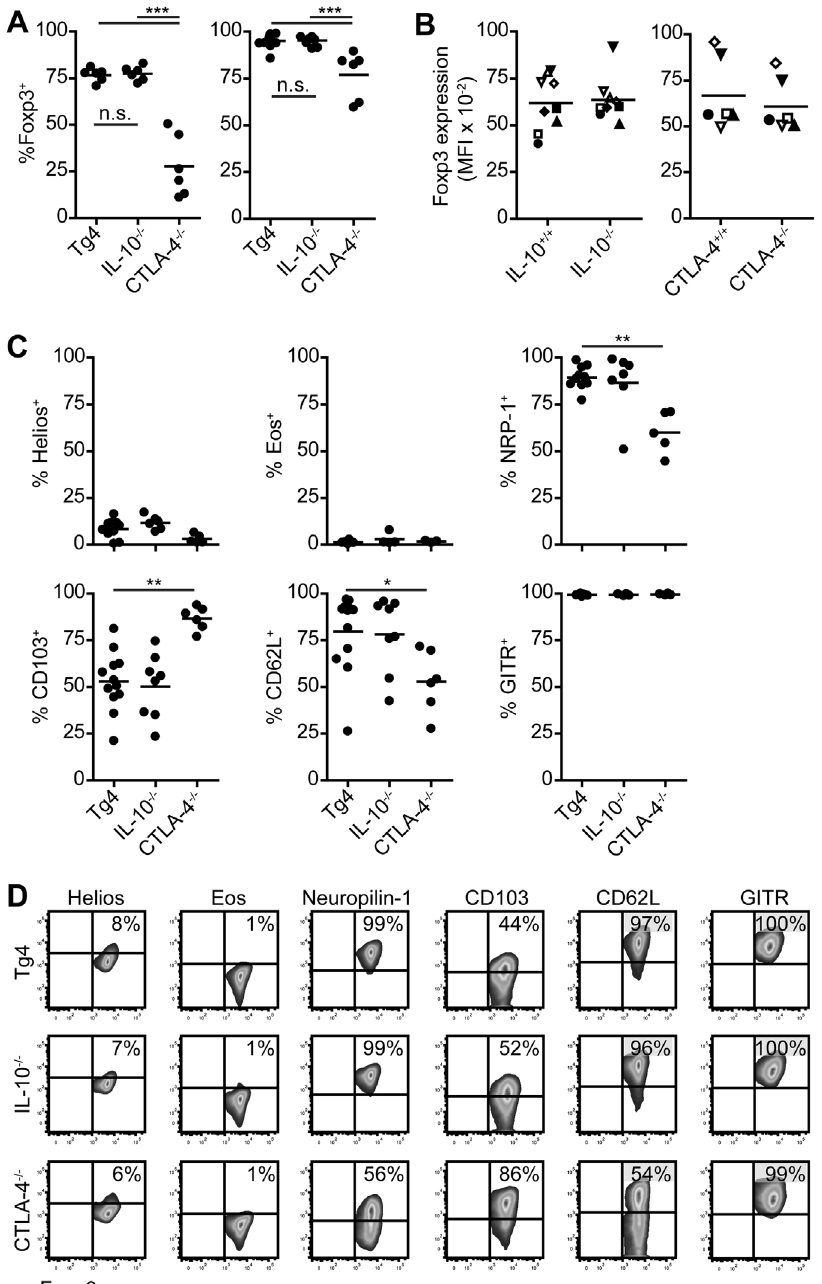
Figure 3. CTLA-4 but not IL-10 deficiency impairs iTreg development. A. Foxp3 expression after 3-day (left) or 7-day (right) culture of naive CD4 + T cells stimulated with plate-bound anti-CD3 and anti-CD28 in the presence of 100 U/ml rhIL-2 and 10 ng/ml rhTGF- b 1 . n=6–14 individual experiments per condition. *** P , 0.001, Tukey’s multiple comparison test. n.s. =not significant. Day 3 and day 7 data are not from the same experiments. B. Median fluorescence of Foxp3 staining on CD4 + Foxp3 + T cells after 7-day culture as in A. Matching symbols in either column in each plot correspond to paired samples. n=6–9. No significant differences; paired, 2-tailed t-test. C + D. Mean expression (C) and representative cytometry plots (D) of transcription factors and surface markers on CD4 + Foxp3 + T cells after 7-day culture as in A. n=3–12 individual experiments per condition. C * P , 0.05, ** P , 0.01, *** P , 0.001, one-way ANOVA with Dunnett’s post-test. doi:10.1371/journal.pone.0108023.g003 subsets, is important for the control of immune responses to self their differentiation. As depicted in Figure 3A, deficiency in antigens. CTLA-4 but not IL-10 impaired anti-CD3 + anti-CD28-mediated Foxp3 induction. The effect of CTLA-4 deficiency on the iTreg cells were generated from naive CD4 + splenic T cells of frequency of Foxp3-expressing cells in the culture was clear from wild-type Tg4, Tg4 IL-10 2 / 2 or Tg4 CTLA-4 2 / 2 mice in order an early stage of differentiation at day 3 of culture (Foxp3 mean 6 to assess the role of these two mediators of immune suppression in